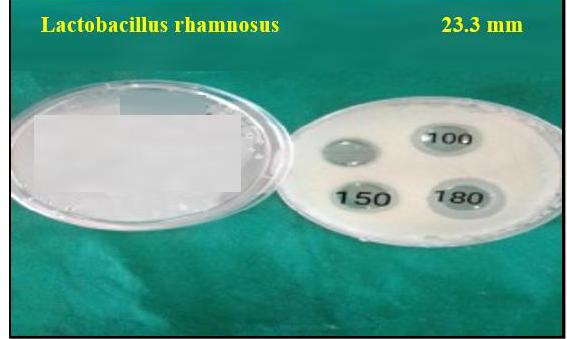
Fig. 5. Effect of L. rhamnosus probiotic on P.